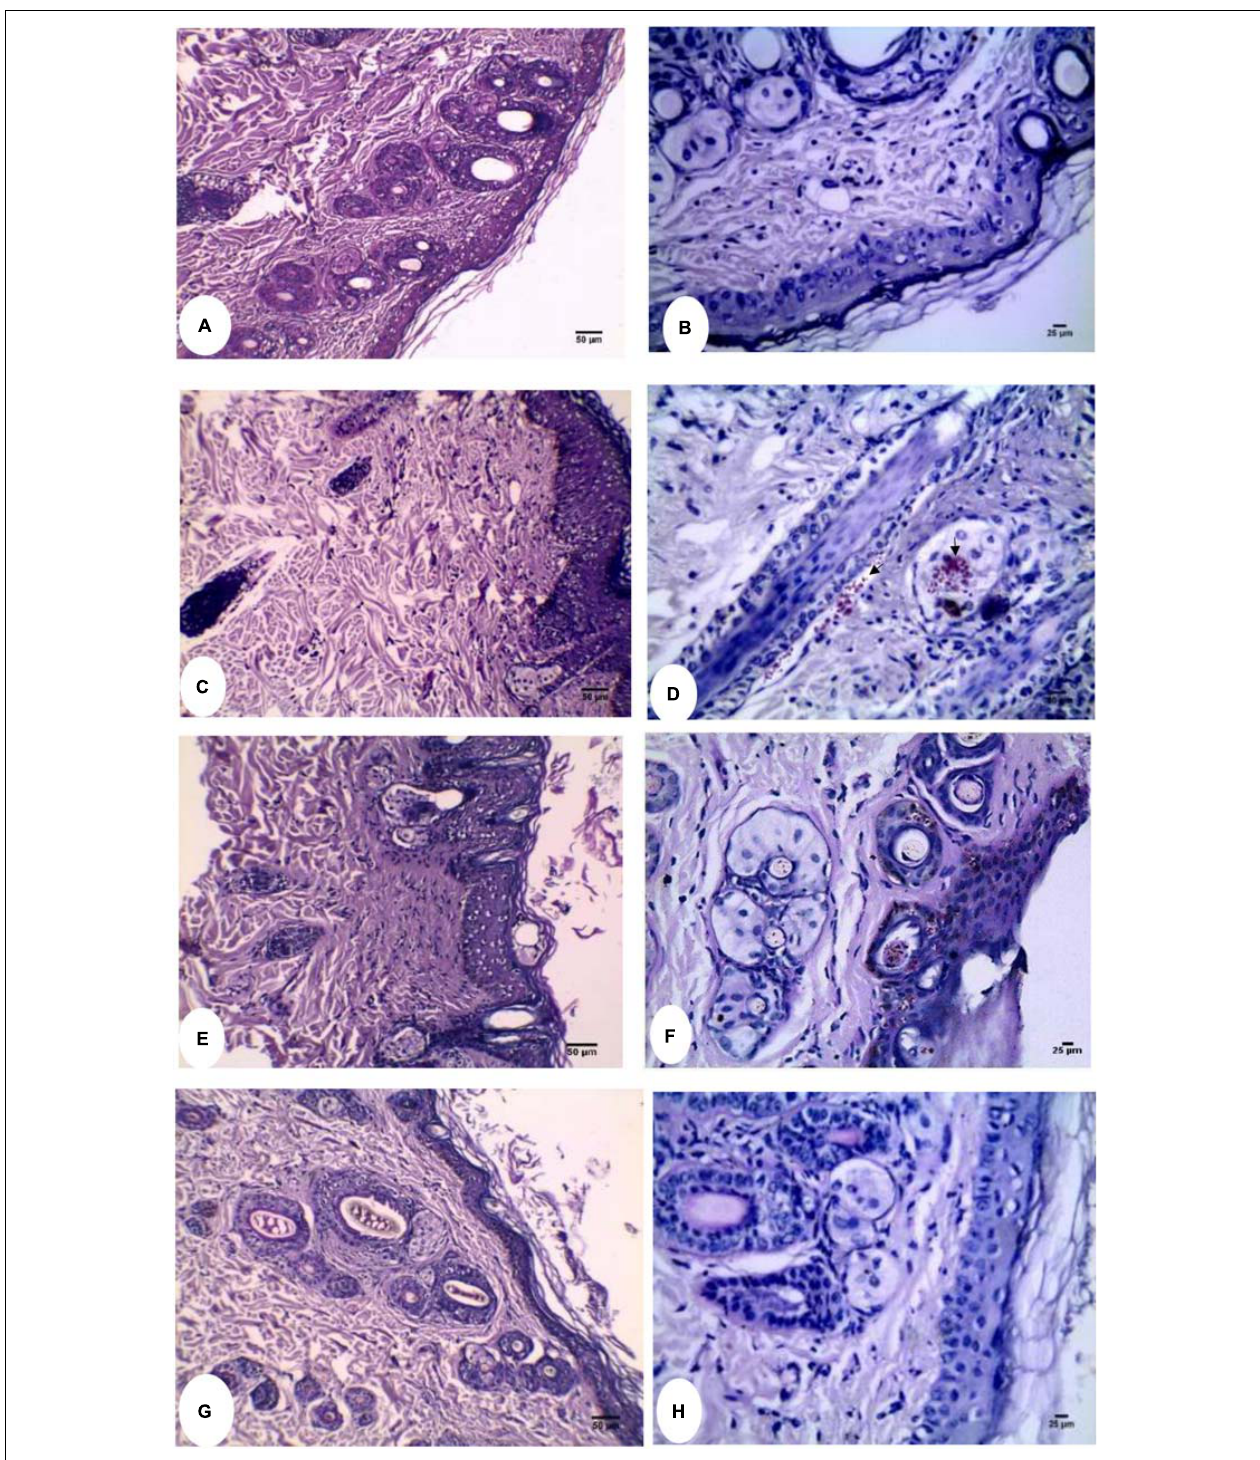
FIGURE 6 | Histopathological evaluation of Guinea pig dermatophytosis model. (A) Normal uninfected control showing thin epidermis and normal dermal structure (H&E). (B) PAS-stained normal uninfected control free from the fungal elements. (C) H&E stained infected untreated control showing thick epidermis, hyperkeratosis, and distorted hair follicles. (D) Arthrospore and hyphal fragments appear bright red (PAS stained) within the hair follicle and sebaceous glands as pointed by arrows. (E) Miconazole received group showing little effect on the epidermal thickness of skin section stained with H&E. (F) Fungal elements were clearly detected in the epidermis as well as the hair follicle (PAS stained). (G) Miconazole/20% urea received group showing recovery of normal skin thickness and structure (H&E). (H) PAS stained skin section of miconazole/20% urea received group showing complete absence of fungal elements. At 200X (A,C,E,G) and 400X (B,D,F,H) .